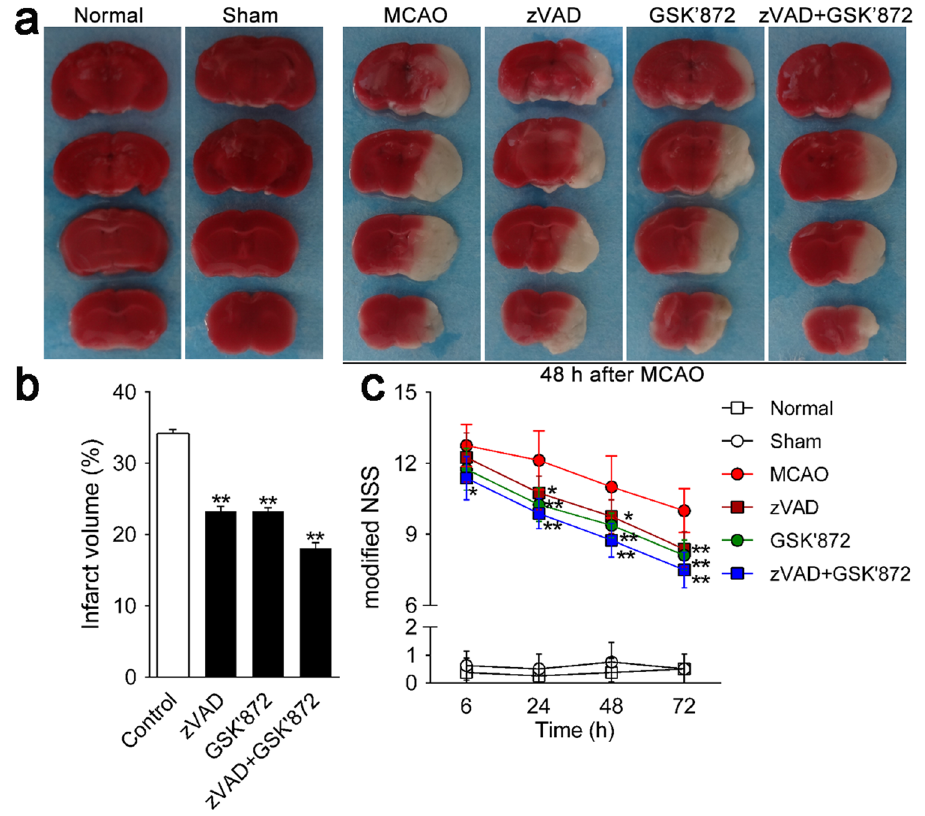
Figure 3. GSK’872 and combinative intervention attenuated ischemic brain injury and neurological deficits induced by MCAO in mice. ( a ) Ischemic areas were visualized by TTC staining at 48 h after MCAO ( n = 3 per group). Normal tissue stained rose-pink, whereas infarct area appeared white. ( b ) Infarct volume was quantified by Image-Pro plus 6.0 software. ( c ) Neurological deficits were evaluated by mNSS at 6, 24, 48 and 72 h after MCAO ( n = 9 per group). Data are presented as the mean ± SD. * p < 0.05, ** p < 0.01 vs . control